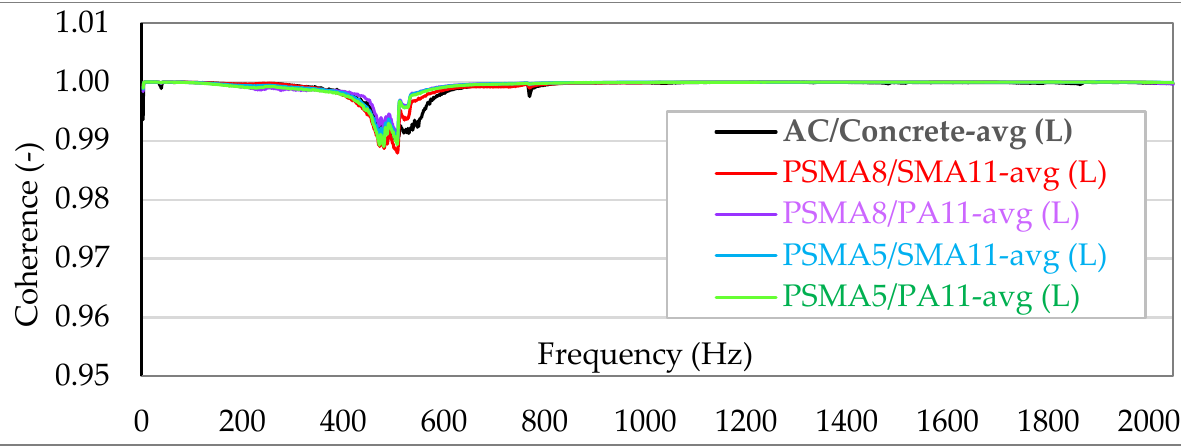
Figure 8. Summary of the coherence for all asphalt mixtures — laboratory measurements (L).